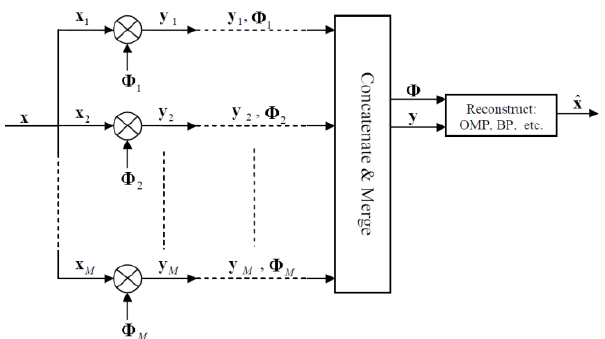
Figure 4. Block diagram of the proposed sampling method in a send-receive